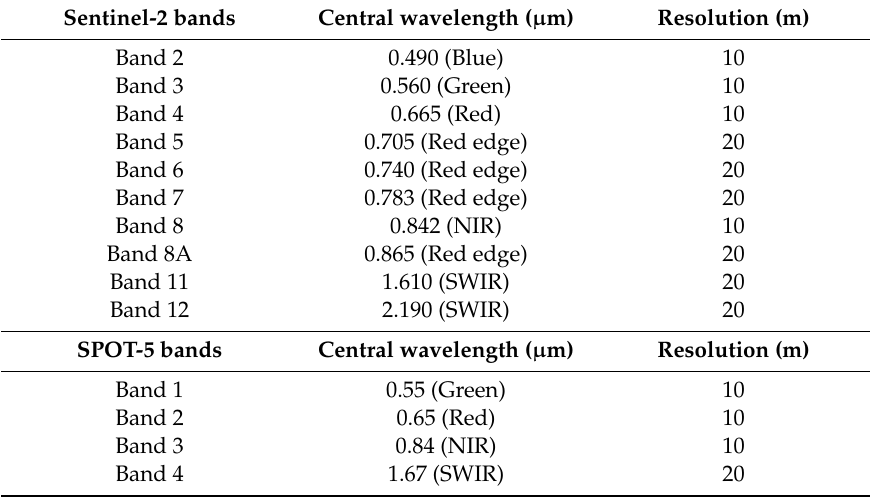
Table 1. Characteristics of the Sentinel-2 and SPOT-5 bands used in segmentation and